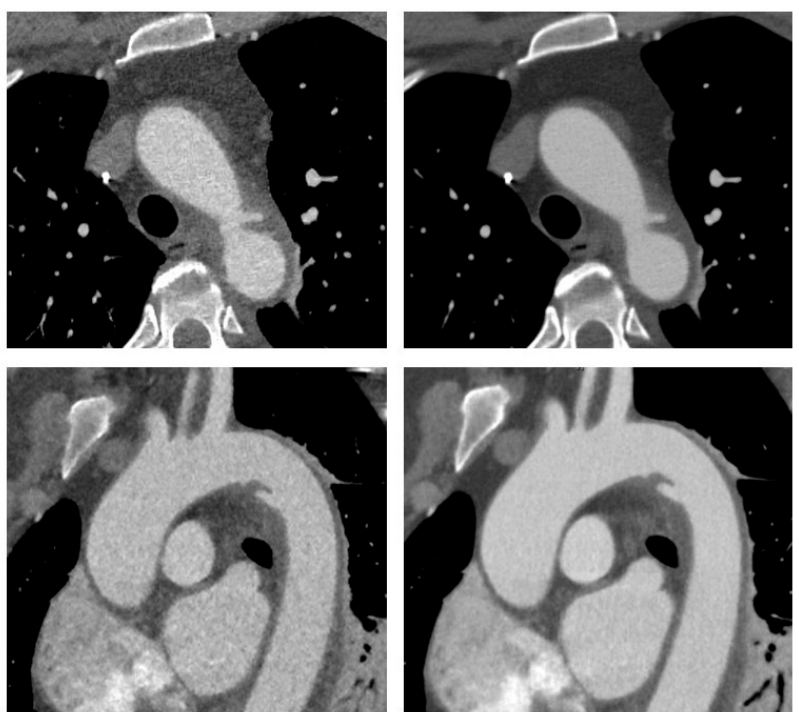
Figure 1. CT angiography of the aorta in a 54-year old woman involved in a motor vehicle accident. Transverse ( upper row ) and sagittal oblique ( lower row ) reconstructions are shown with adaptive statistical iterative reconstruction V (ASIR-V 60%, left ) and deep learning-based image reconstruction–high strength (DLIR-H, right ). Images demonstrate traumatic injury to the aortic isthmus with adjacent hematoma indicating contained aortic rupture. The patient was hemodynamically stable and was successfully treated with implantation of an aortic stentgraft.